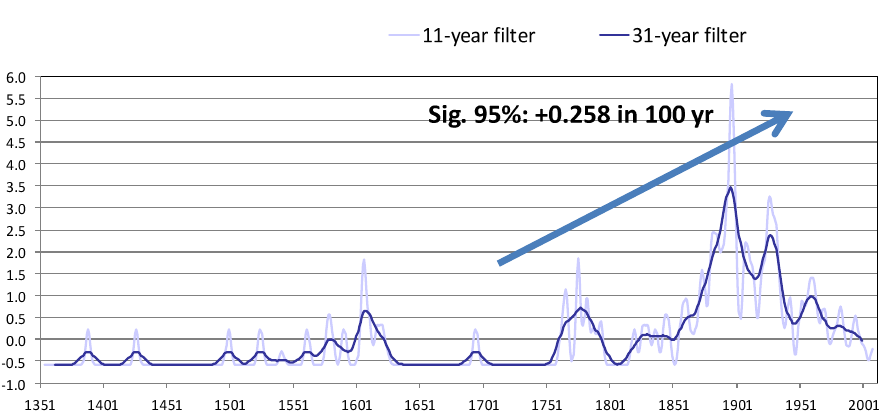
Figure 5. Temporal evolution of catastrophic (a) , extraordinary (b) and total (c) urban flood index series for Barcelona (1351–2012). Data are smoothed by low-pass Gaussian filters of 31 and 11 years. The result of applying a trend analysis for each series is also